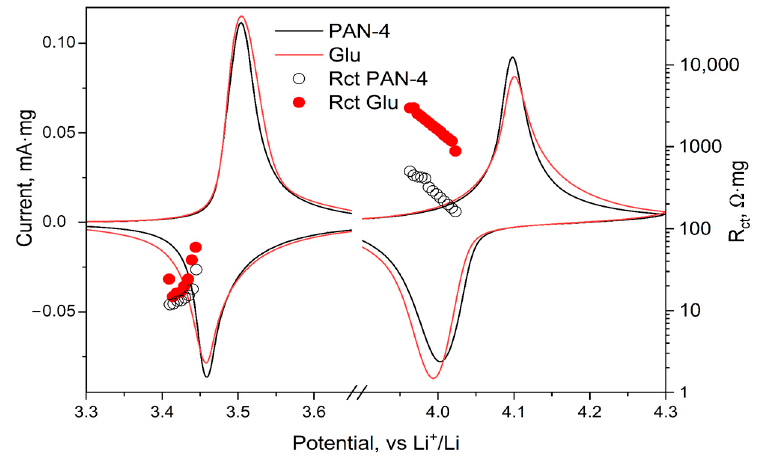
Figure 6. The charge transfer resistance in the single-phase regions and CVs of PAN-4 and Glu samples.